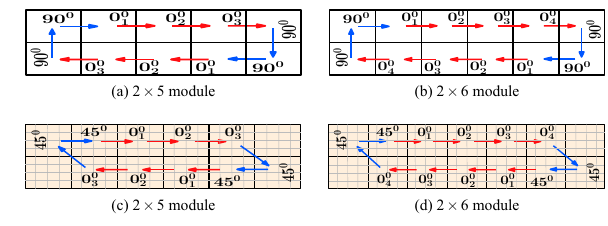
Fig. 8 2 × 5 and 2 × 6 mixing module